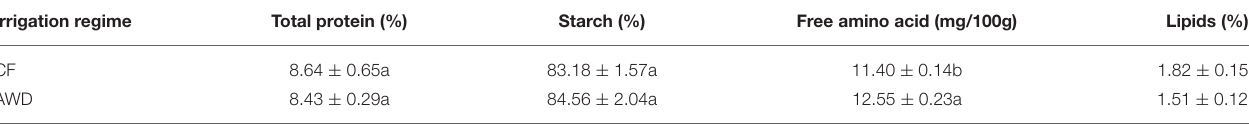
TABLE 2 | Total protein, starch, free amino acid, and lipids content of milled rice. Irrigation